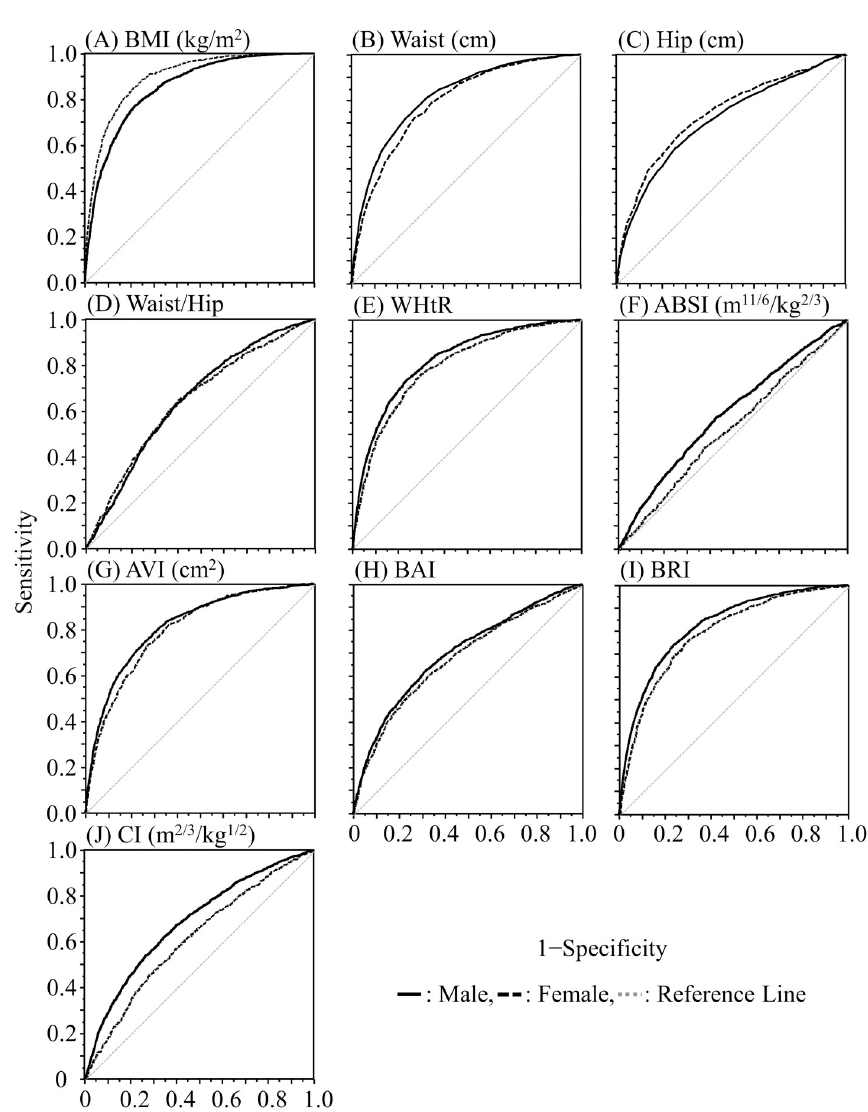
Fig 2. ROC curves for masked obesity of each anthropometric measure and body